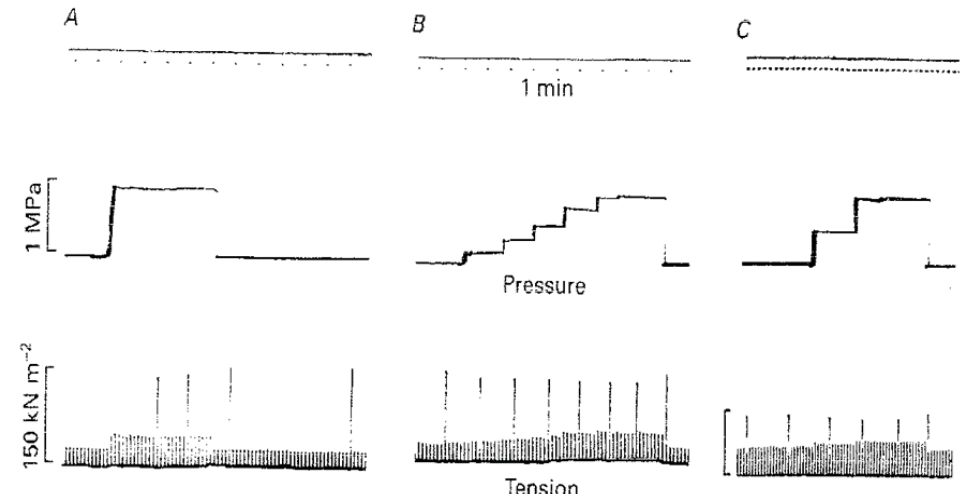
Figure 7. Chart recordings of tension (lower trace) and pressure (upper trace): ( A , B ) are from one fibre preparation (( C ) from another), twitch contractions at 1/10 s and tetani infrequently. Amplitude of twitch is higher whereas that of tetani lower at high pressure (adapted from [18]). A twitch contraction is the transient tension response to a single stimulus (+single action potential leading to the release of Calcium) and tension rises to a peak and relaxes.